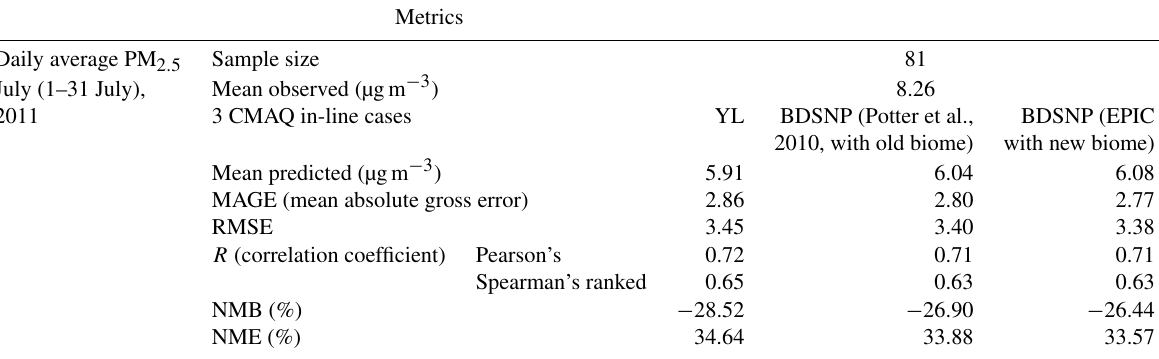
Table 2. Aggregated performance statistics of CMAQ modeled daily average PM 2 . 5 for stations showing sensitivities with change in soil NO between the YL scheme and our two in-line BDSNP implementations (“old” and “new”) for CONUS in July 2011 as compared to observations at these sites. Metrics Daily average PM 2 .